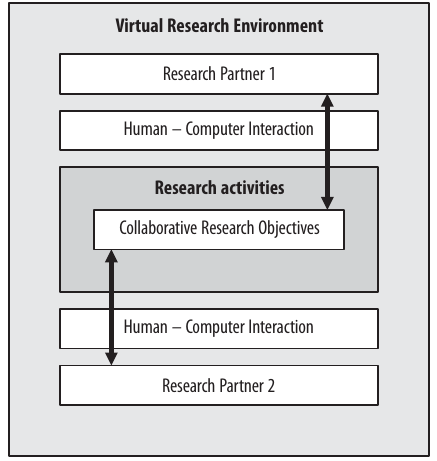
Figure 1. The structure of a typical